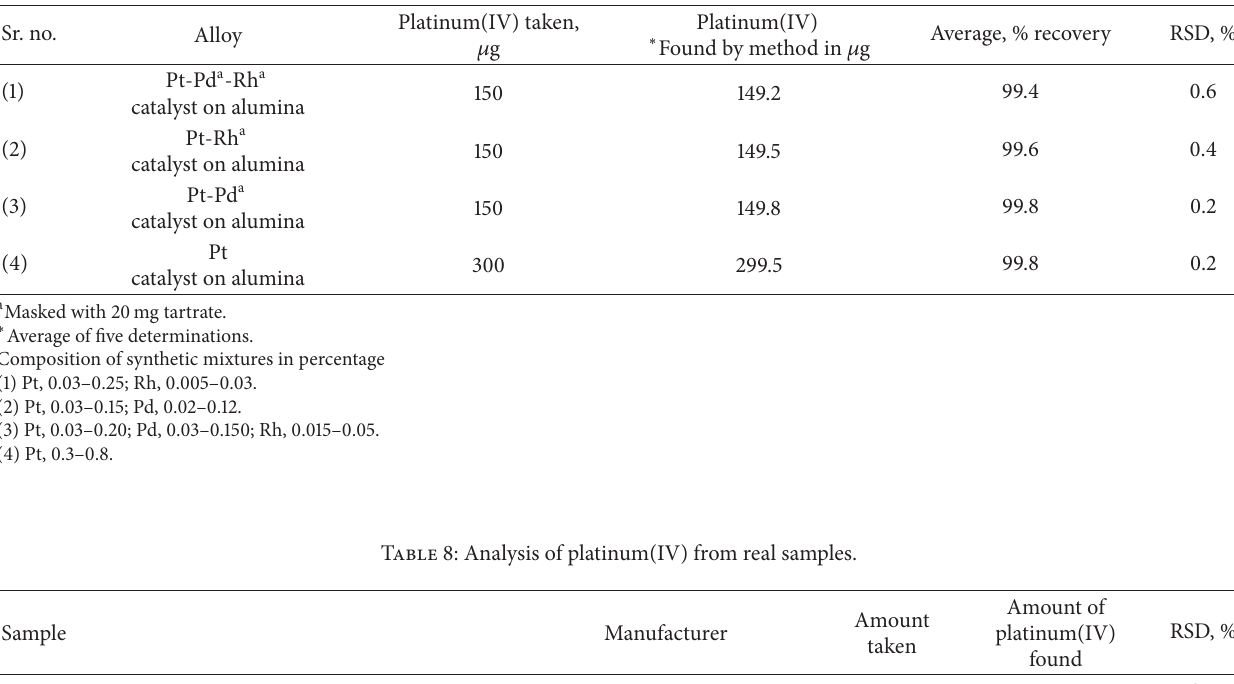
Table 7: Determination of platinum(IV) from catalysts.